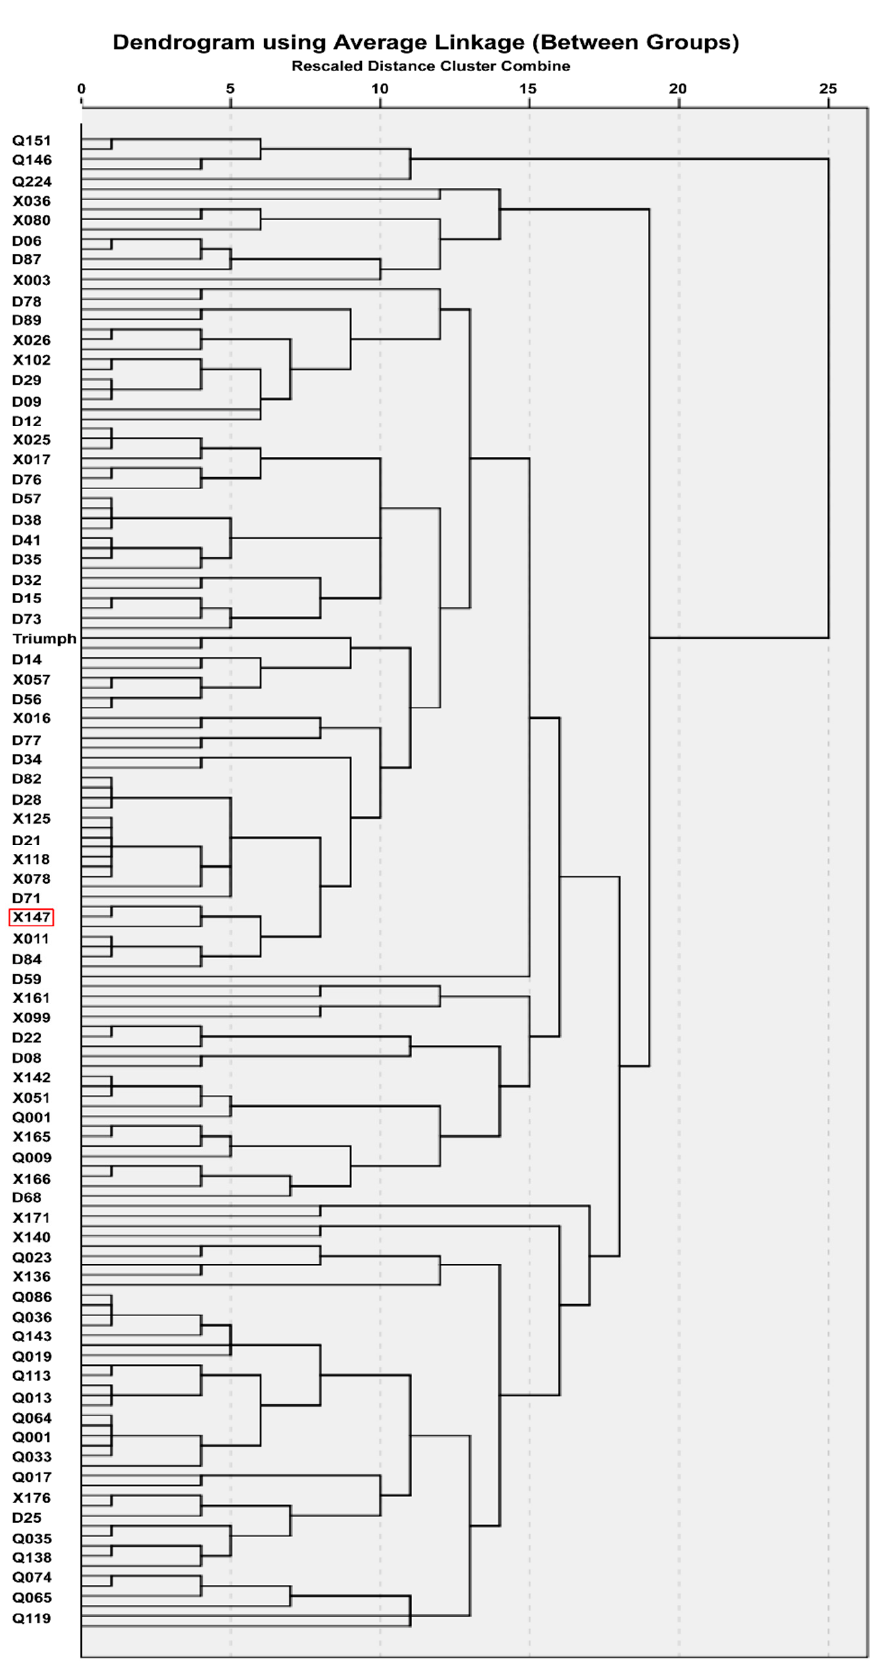
Figure 1. Genetic cluster of 125 barley accessions by SSR markers.